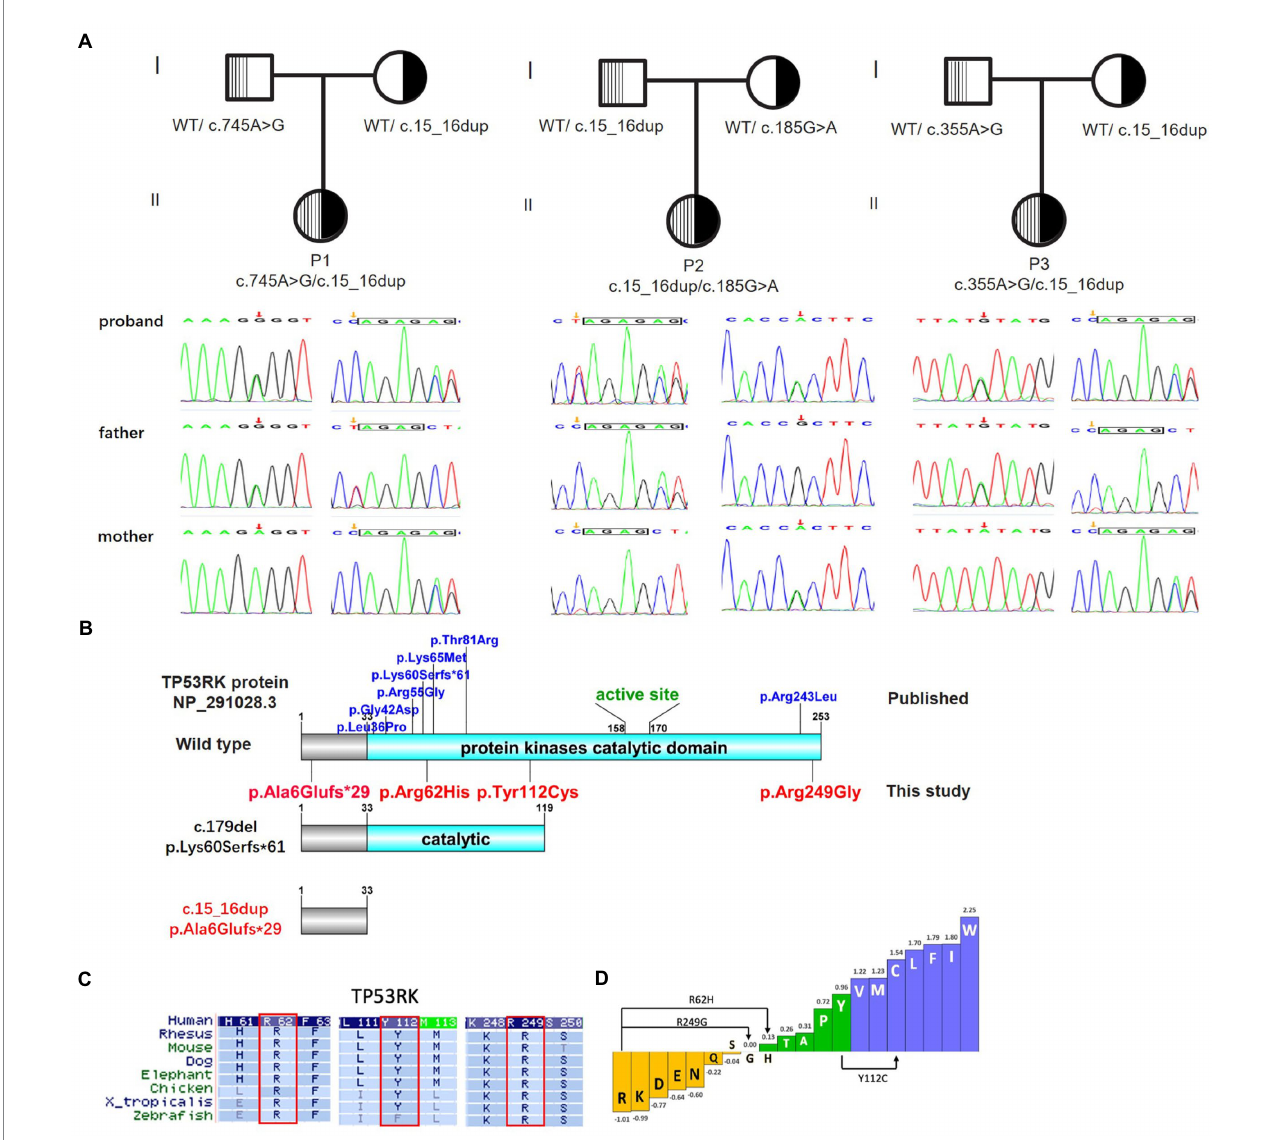
FIGURE 3 Biallelic variants in TP53RK cause Galloway–Mowat syndrome in three unrelated Chinese patients without the nephrotic syndrome. (A) The pedigree of the three unrelated GAMOS4 families for whole-exome sequencing (WES) and Sanger sequencing to verify the identified TP53RK variants. (B) Protein domain pattern map of human TP53RK and position of mutations. (C) Multiple amino acid sequence alignment of TP53RK5 among different species on missense variants (R62H, Y112C, and R249G). (D) Enhanced hydrophobicity properties of three missense variants (R62H, Y112C, and